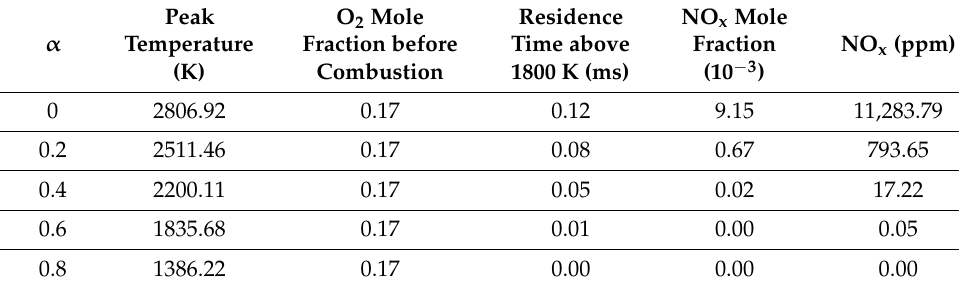
Figure 14. The variation curve NO x emissions under different α . Table 4. The impact of α on NO x formation conditions.